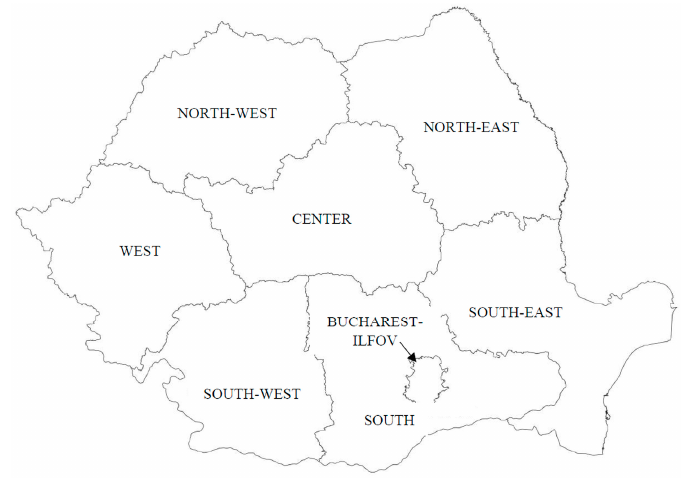
Figure 1. Romania—the geographic map by regions. Deaths analysis: The deaths have been analyzed as annual number and percentage change in 2016/2019, compared to the baseline (2001).